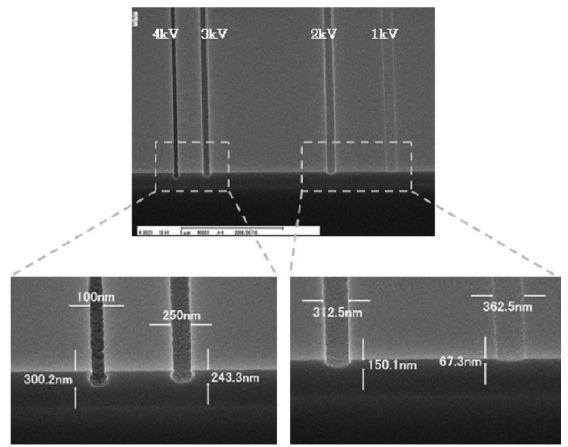
Figure 36. Three ‐ dimensional spin on glass mold